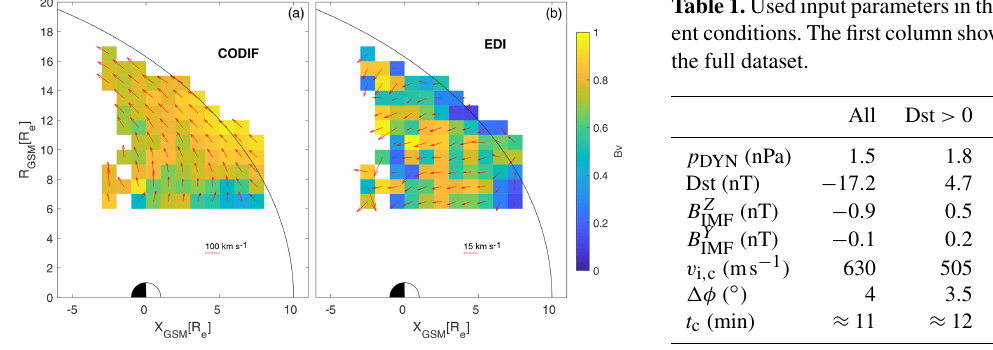
Figure 6. Distribution of average parallel and convection velocities in the cusps and plasma mantle regions. Lengths of vectors repre- sent the convection velocity in each bin, calculated as the average magnitude of vectors. Colors indicate the bias value in each bin, a measure of directional variability. Panel (a) depicts parallel ve- locities obtained using CODIF data; panel (b) depicts convection velocities obtained using EDI data. Vectors are scaled as given in the lower right corner of each panel.